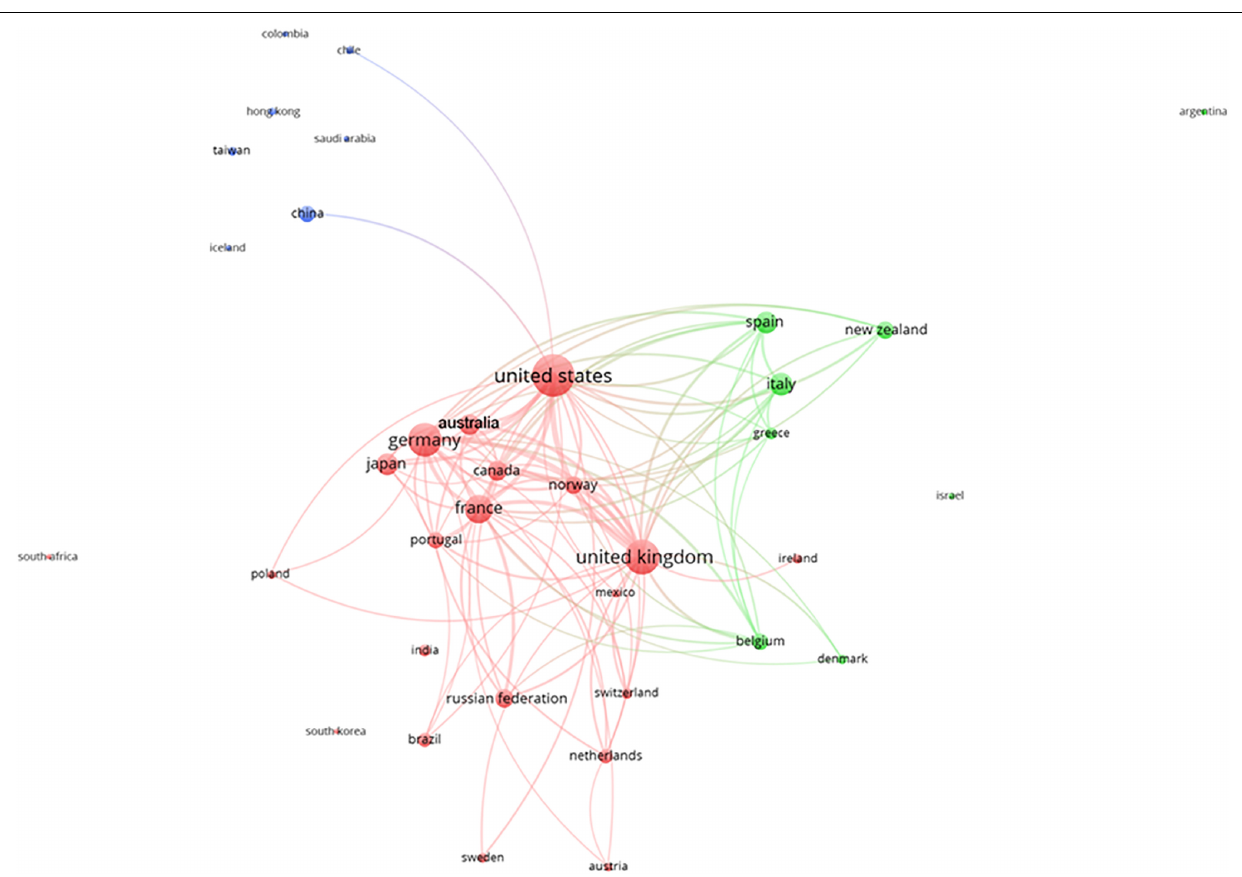
FIGURE 7 | Clustering of the collaborations among different countries (based on deep-sea biodiversity publications co-authored by scientists of different institutions). Different colors represent different clusters of countries. Lines indicate at least 100 co-occurrence links between